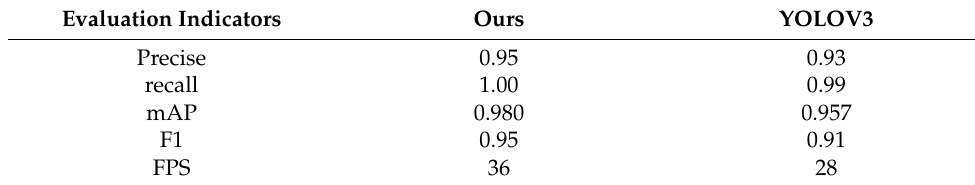
Figure 16. Graph of the results of various ship indicators on the test set. Table 6. Overall index results on the test